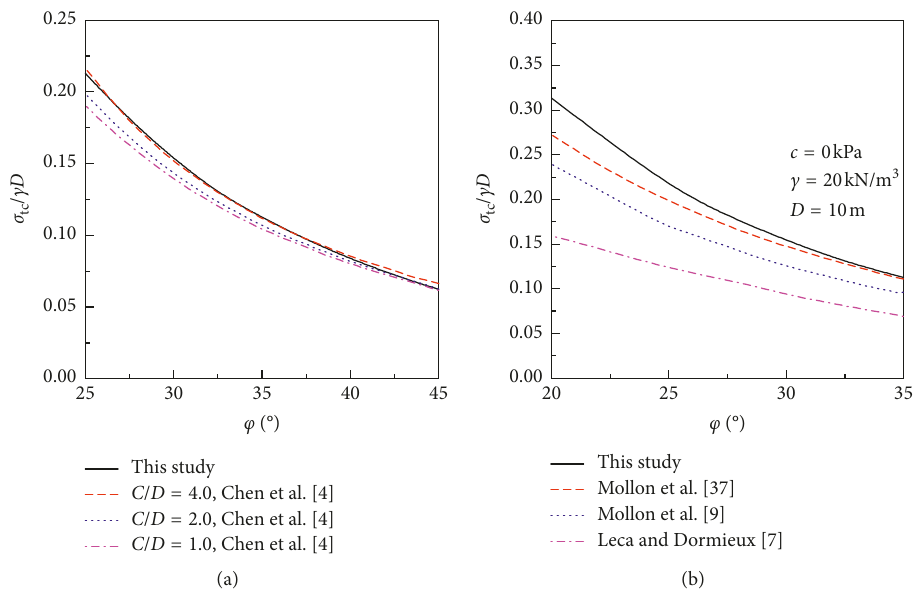
Figure 4: Comparisons of the critical results for tunnel face in cohesionless soils.